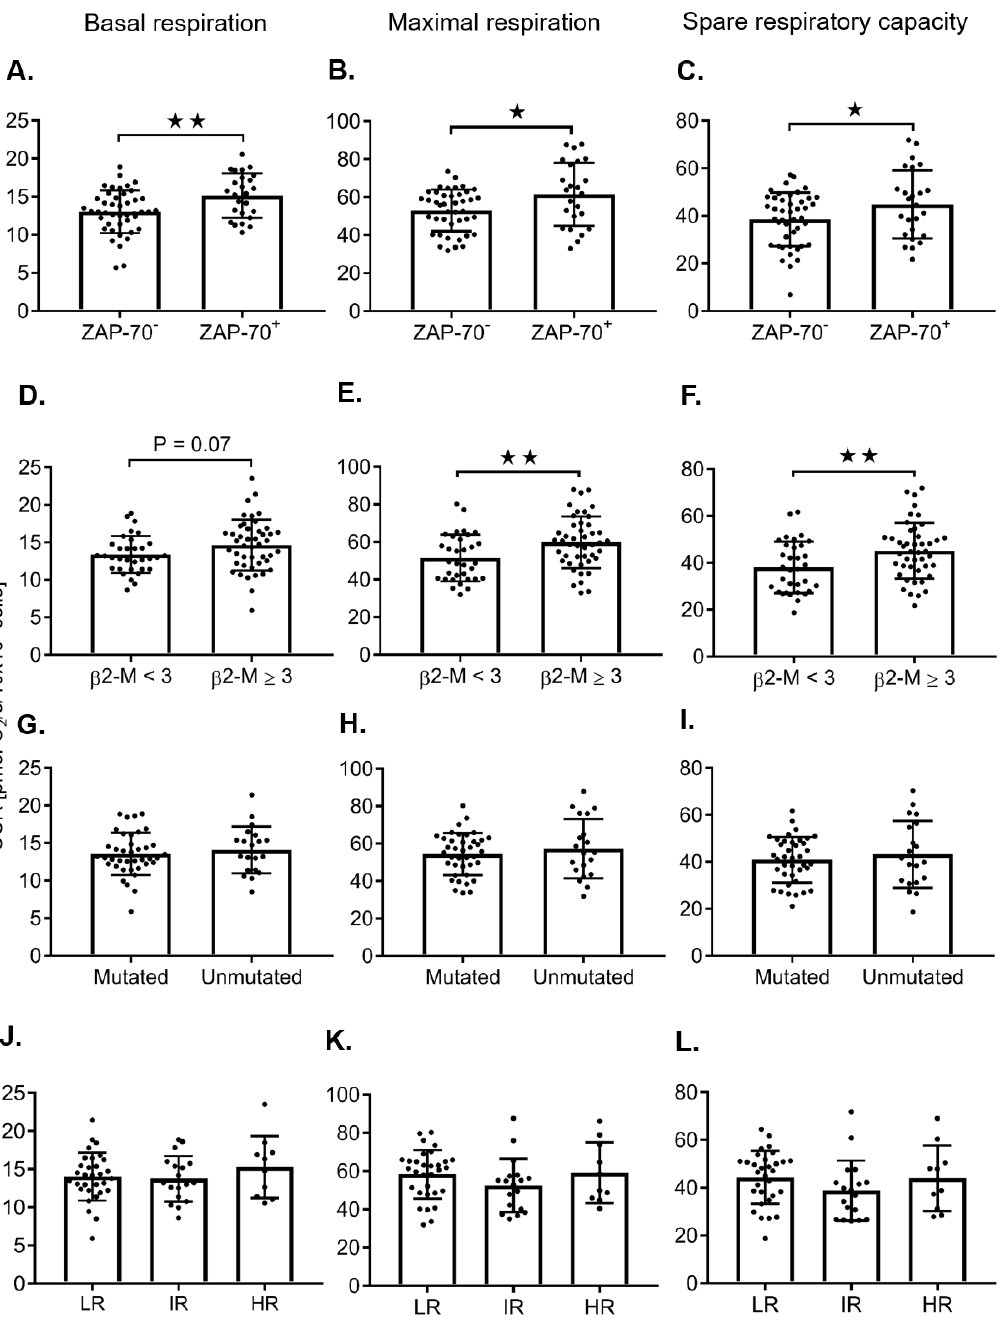
Figure 2. The influence of clinical prognostic markers zeta-chain-associated protein of 70 kD (ZAP-70), β 2-microglobulin ( β 2-M), immunoglobulin variable heavy chain (IgVH) mutation status, and fluorescence in situ hybridization (FISH) on mitochondrial bioenergetic profiles in freshly isolated CLL cells. The correlation of clinical prognostic markers, ZAP-70 (ZAP-70 − vs. ZAP-70 + ; A – C ; N = 41 / 25), β 2-M ( < 3 vs. ≥ 3 µ M; D – F ; N = 33 / 45), IgVH (mutated vs. unmutated; G – I ; N = 39 / 20), and FISH (low risk, LR vs. intermediate risk, IR vs. high risk, HR; J – L ; N = 31 / 18 / 10) with basal respiration, maximal respiration, and the spare respiratory capacity, respectively, are summarized in freshly isolated CLL cells (10 × 10 6 cells). Values are the mean ± S.D., * p < 0.05, ** p < 0.01 (unpaired two-tailed Student’s t-